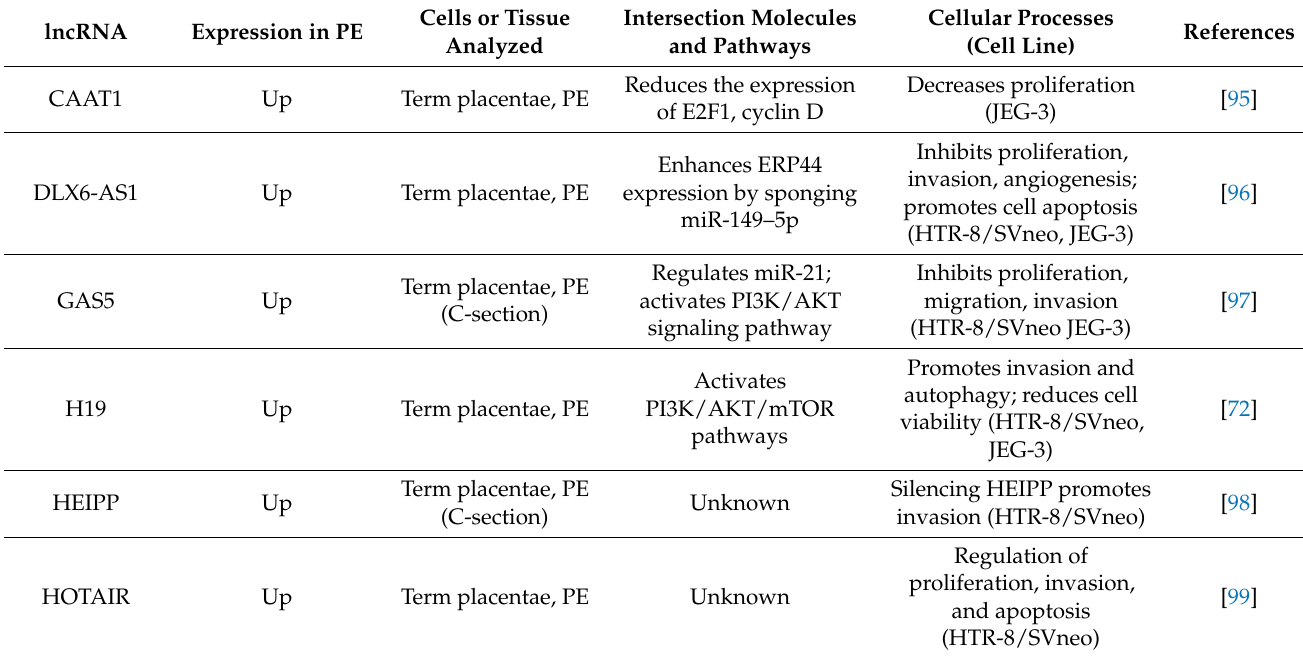
Table 1. Summary of lncRNAs associated with